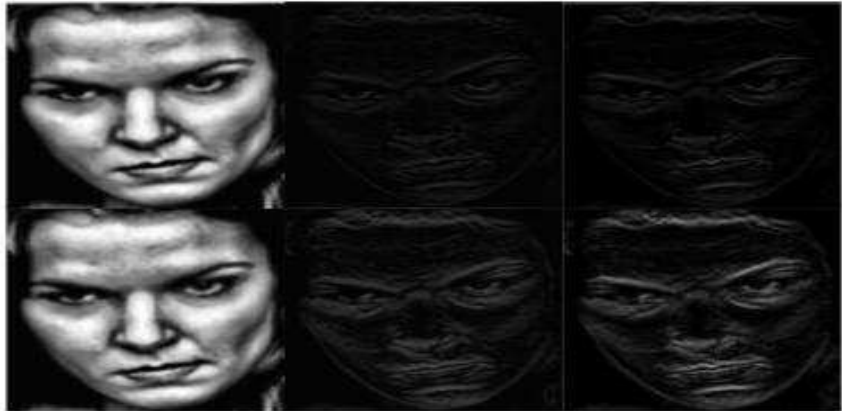
Figure 5. The illumination normalized expression samples of frequency domain transform based on WAVEDEC2 in RAF Compound. The upper row denotes illumination normalized expression samples of WAVEDEC2 transform based on sym1; the lower row denotes illumination normalized expression samples of WAVEDEC2 transform based on rbio3.1. Copyright reference: http://www.whdeng.cn/